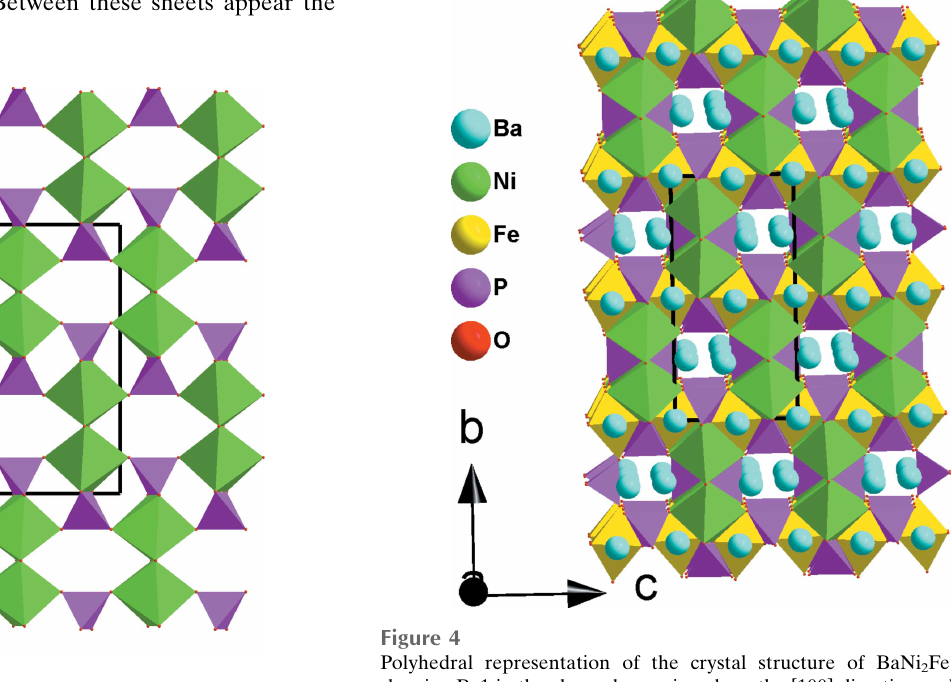
Figure 2 Projection of a (100) sheet along [100] showing the [Ni 2 P(2) 2 O 14 ] unit.